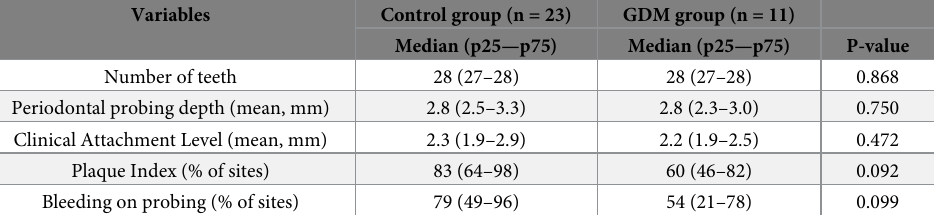
Table 2. Description of periodontal characteristics of control group (healthy pregnancies) and Gestational Dia- betic Mellitus pregnant women (GDM group) at 11–14 weeks of